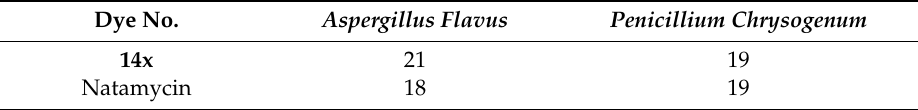
Table 6. Antifungal activity of the treated dyed polyester